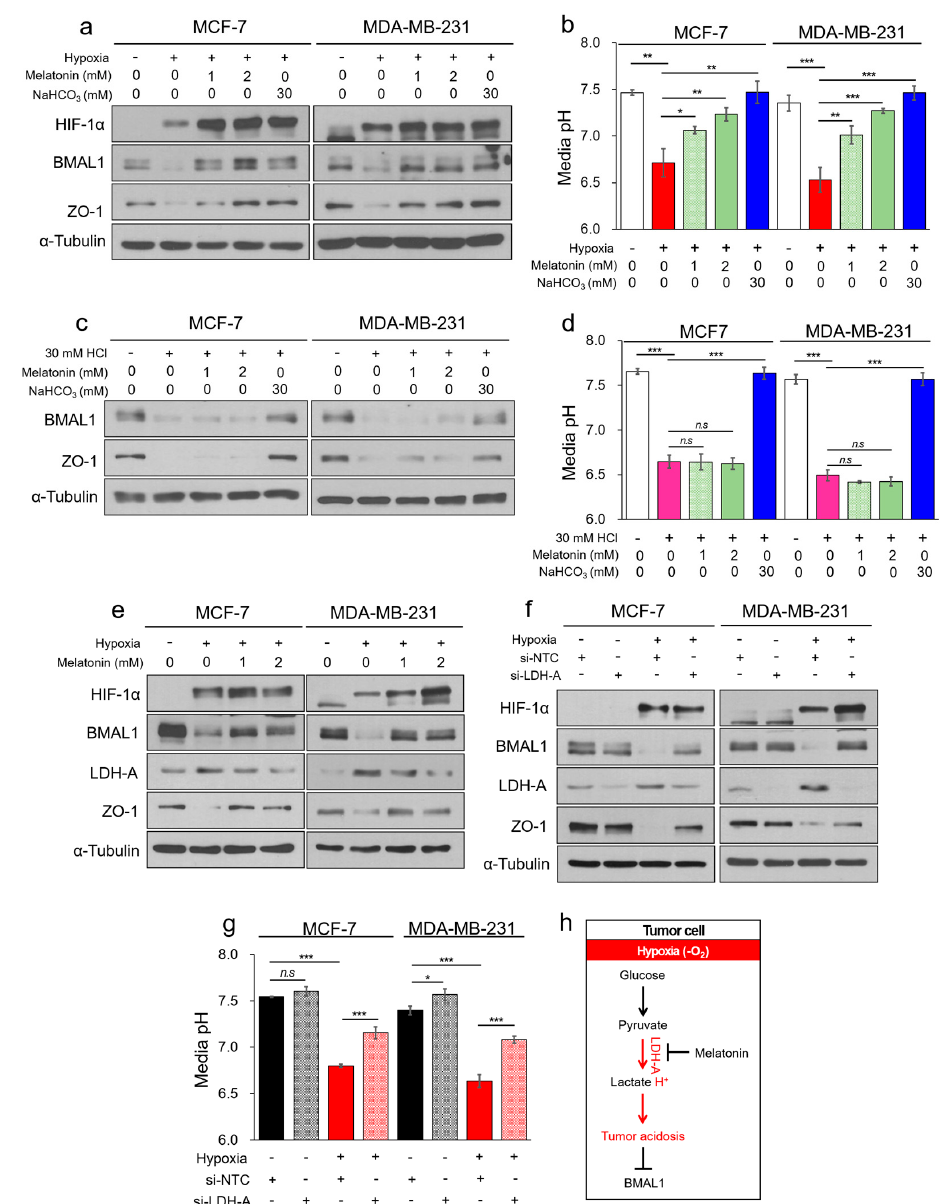
Figure 5. Melatonin attenuates decrease of BMAL1 expression by inhibiting hypoxia-mediated LDH-A in breast cancer cells. ( a , b ) MCF-7 and MDA-MB-231 were incubated in normoxia or 2% O 2 hypoxia with melatonin or NaHCO 3 for 48 h. Cell lysates were analyzed by immunoblotting ( a ) and pH of the cultured media was immediately measured using a pH meter ( b ). ( c , d ) MCF-7 and MDA-MB-231 were incubated in acidic condition with melatonin or NaHCO 3 for 24 h. Cell lysates were analyzed by immunoblotting ( c ) and pH of the cultured media was immediately measured using a pH meter ( d ). ( e ) MCF-7 and MDA-MB-231 were incubated in normoxia or 2% O 2 hypoxia with melatonin for 48 h. Cell lysates were analyzed by immunoblotting. ( f , g ) MCF-7 and MDA-MB-231 were transfected with si-NTC or si-LDH-A, and cells were incubated in normoxia or 2% O 2 hypoxia for 48 h. Cell lysates were determined by immunoblotting ( f ) and pH of the cultured media was immediately measured using a pH meter ( g ). ( h ) The summarization of pathway that melatonin attenuates acidosis-mediated decrease of BMAL1 by inhibiting LDH-A in hypoxia. Data represent the mean ± SD, n = 3. * p < 0.05, ** p < 0.01, and *** p < 0.001 vs. the control group or between two groups by a Student’s t